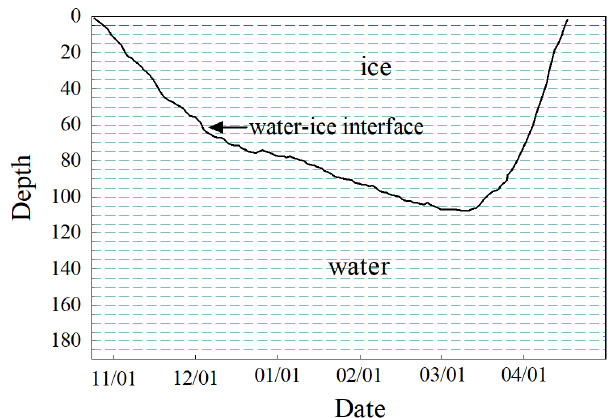
Figure 3. The processes of lake ice growing and melting (short dash lines are the sensors’ horizontal planes).